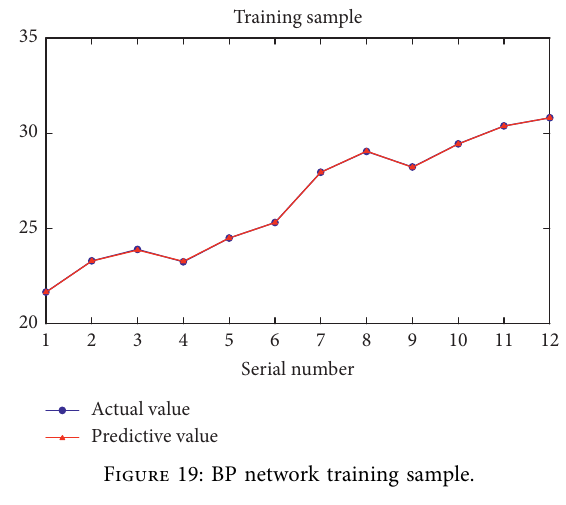
Figure 19: BP network training sample.